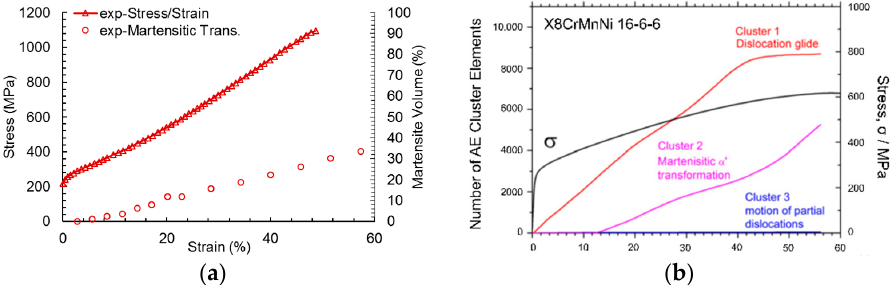
Figure 14. Experimental results of cast X8CrMnNi16-6-6 steel: ( a ) flow curve and martensitic transformation data measured by Fisher ferritoscope; ( b ) stress/strain plot with consolidated in situ acoustic emission test data (reprinted with permission from [46], Elsevier, 2013).